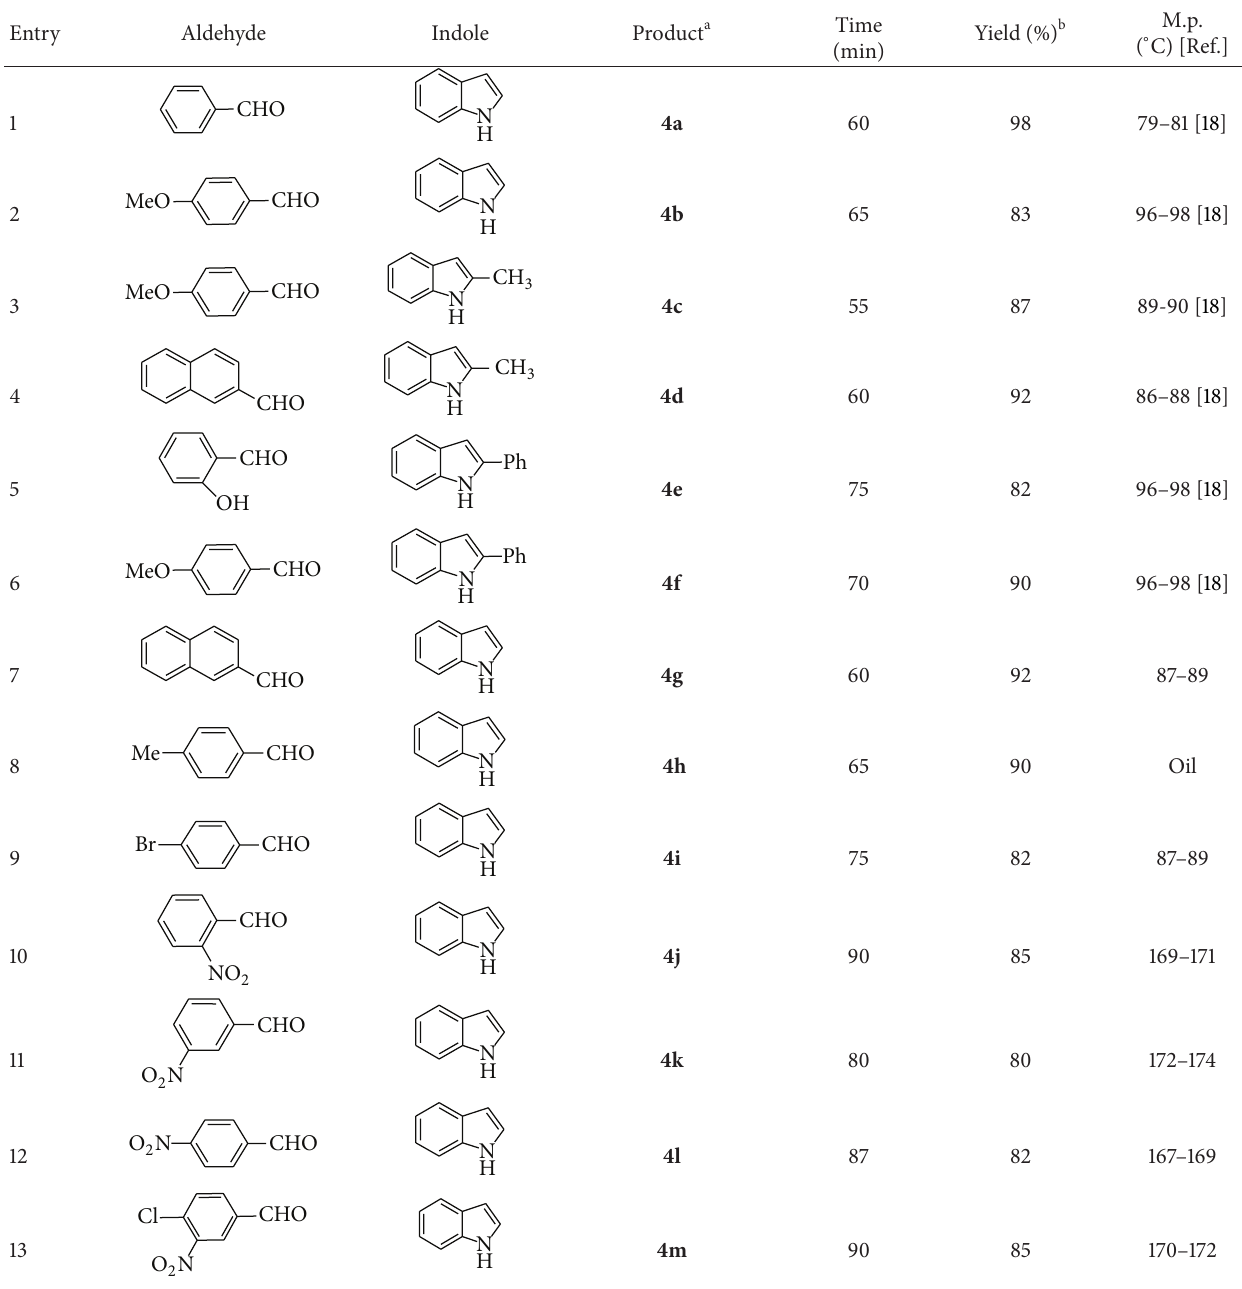
Table 5: Condensation of aromatic aldehyde, kojic acid, and indole derivatives in the presence of Kaolin/Ag nanocomposite catalyst. Entry Aldehyde Indole Product